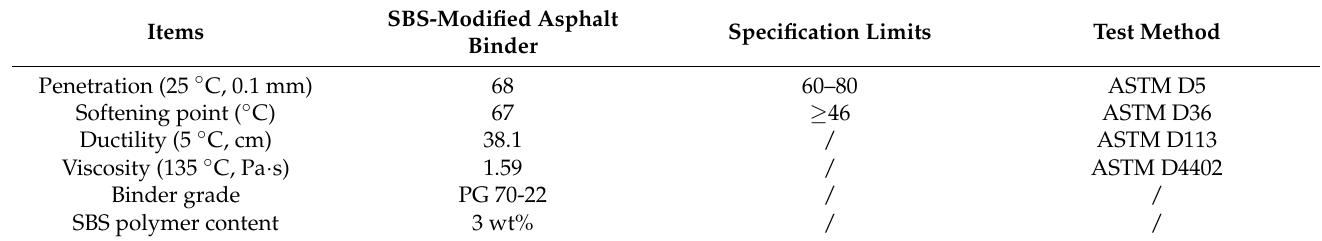
Table 2. General properties of SBS ‐ modified asphalt binder.